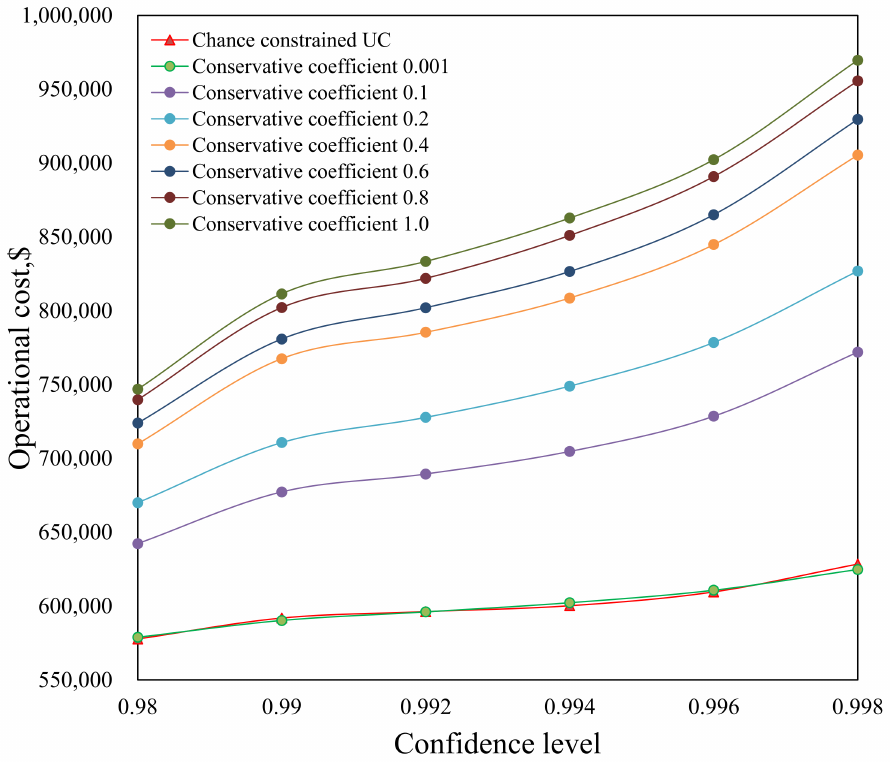
Figure 9. Comparison of model calculation results.